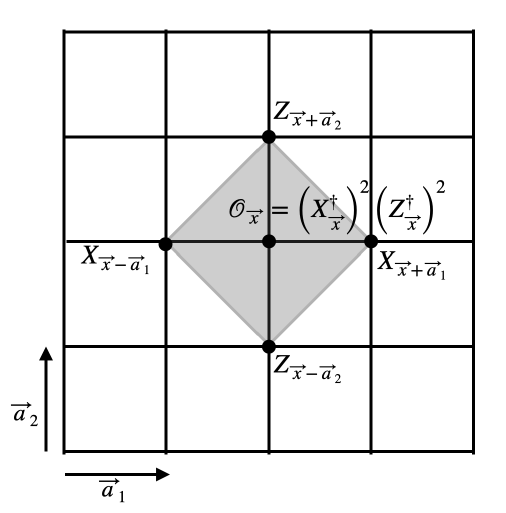
and ⃗ a and the plaquette operators 1 2